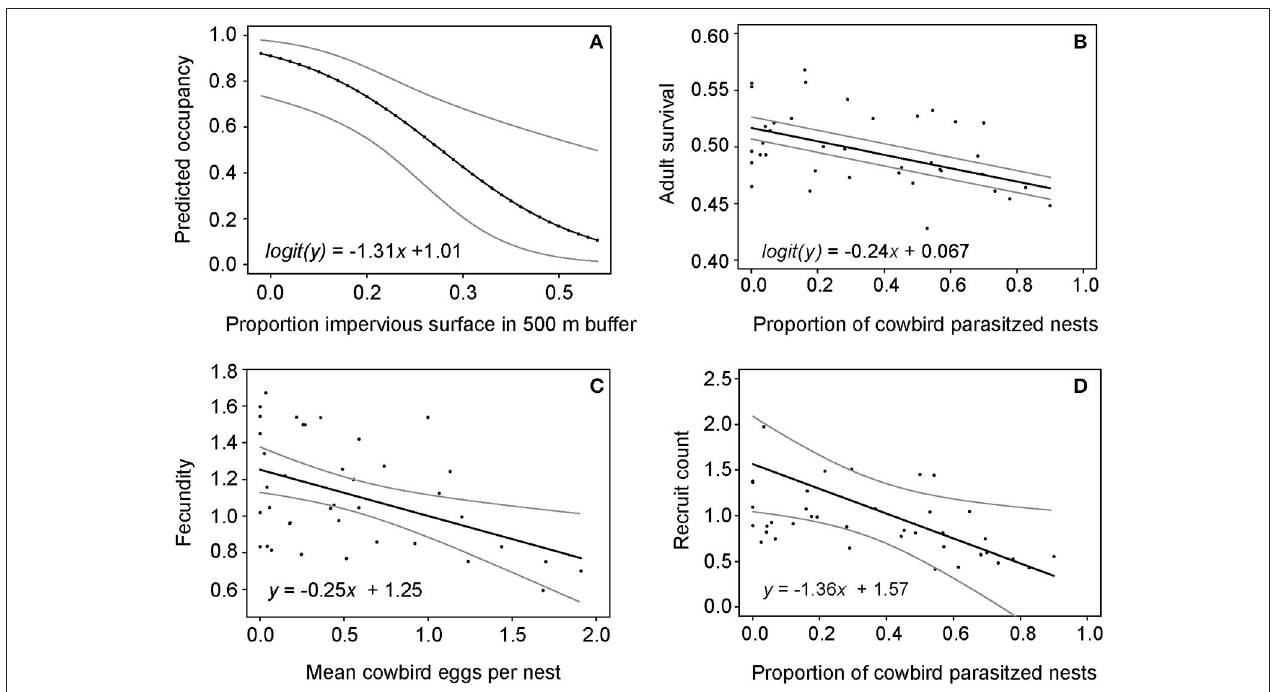
FIGURE 2 | Regression models showing relationships between (A) proportion of impervious surface (within 500m buffer around sites) and site occupancy, (B) proportion of cowbird-parasitized nests and adult wood thrush survival, (C) mean cowbird eggs laid per nest and wood thrush fecundity (mean fledglings per female), and (D) proportion of cowbird parasitized nests and mean number of recruited individuals per year.